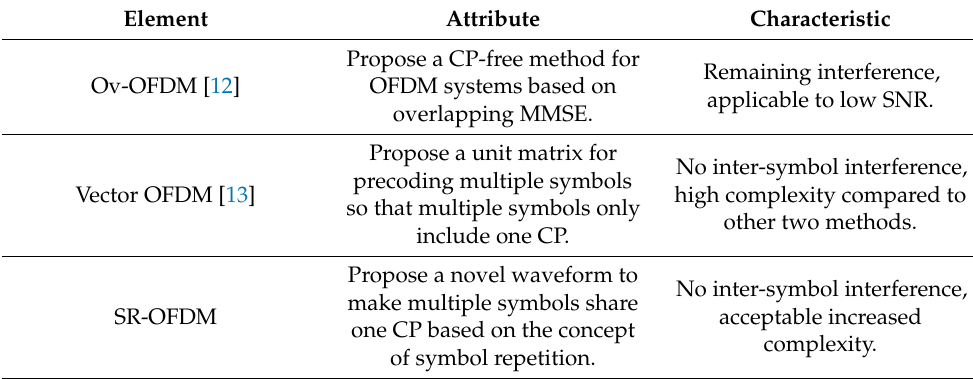
Table 4. Comparison of different CP reduction